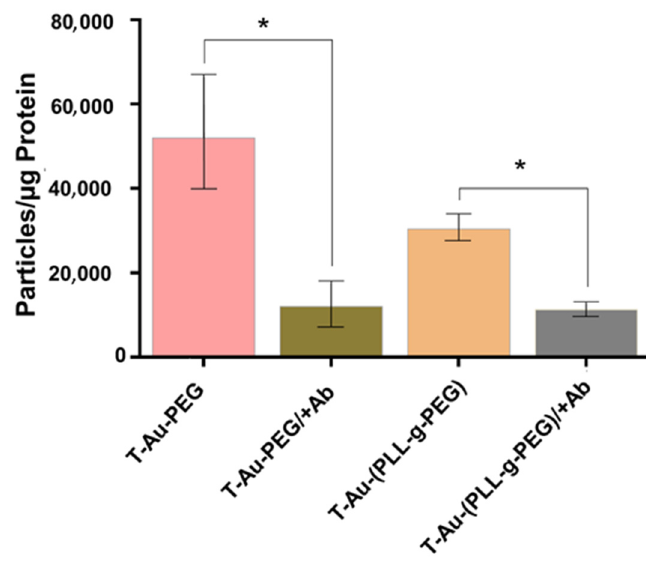
Figure 5. Graphical representation of the laminin dependent uptake of targeted nanoparticles in HeLa cells. Data is represented as mean ± SD ( n = 3). (* p < 0.05).